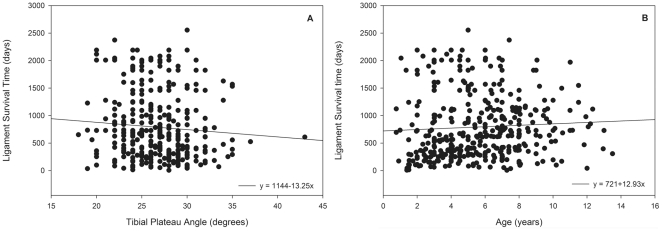
Tibial plateau angle (TPA) and age influence contralateral cranial cruciate ligament (CrCL) survival over time in dogs diagnosed with unilateral CrCL rupture.(A) Increasing TPA was associated with decreased contralateral CrCL survival, whereas increasing age at diagnosis was associated with increased contralateral CrCL survival (B). However, these effects appear minor, as the slope of the regression lines is small and data points are widely scattered.